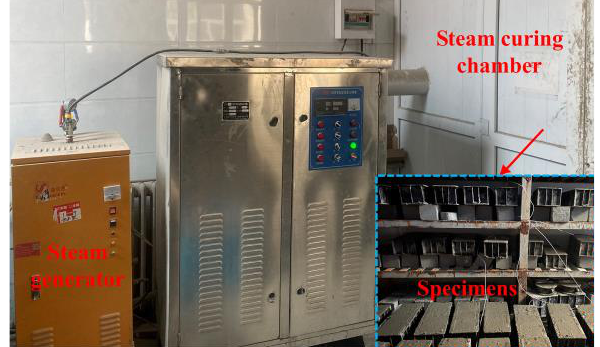
Figure 5. Steam curing equipment.